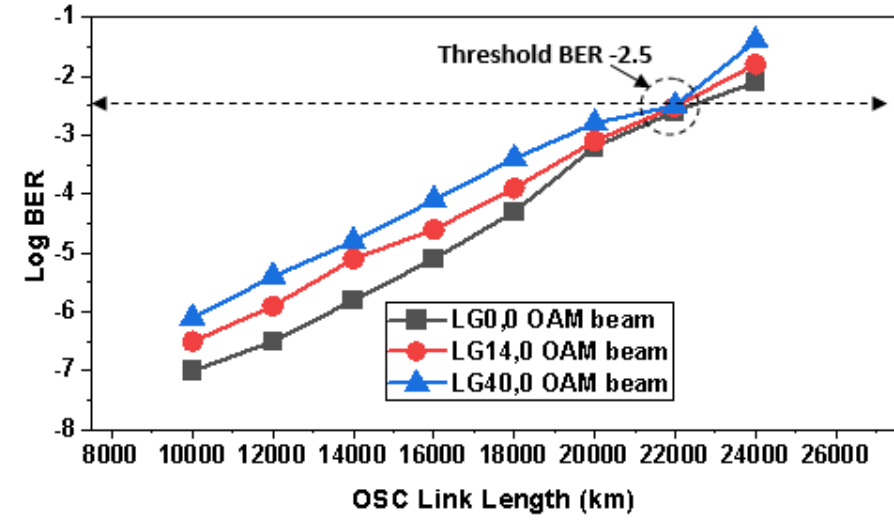
Figure 9. Variation of BER for OSC link length for LG0,0, LG14,0, and LG40,0 OAM beams. With the increase in the OSC link length, symbols at the receiver deteriorate and dis ‐ rors in the 256 ‐ QAM symbols, attenuation, scattering, and nonlinear effects at high power